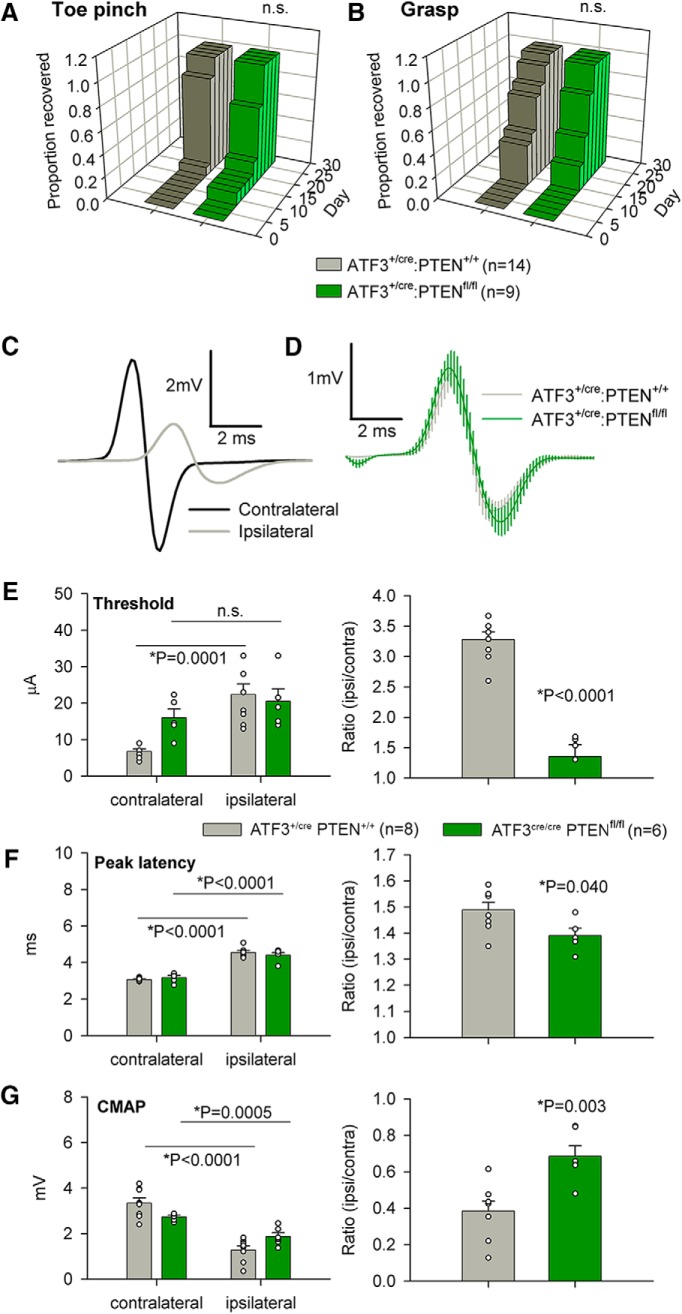
Axotomy-induced PTEN deletion and improves functional recovery following sciatic nerve crush. A, B, While there was no difference in recovery of reflex nociception or grasping in mice with floxed PTEN alleles (log rank Mantel–Cox test, n = 14 and n = 9 for ATF3+/cre:PTEN+/+ and ATF3+/cre:PTENfl/fl, respectively), EMG responses (C–G) indicated enhanced recovery of neuromuscular function. C, D, Representative EMG traces from ipsilateral and contralateral sides of an ATF3+/cre:PTEN+/+ mouse 28 d after sciatic nerve crush (C) and composite traces from eight ATF3+/cre:PTEN+/+ mice and six ATF3cre/cre:PTENfl/fl mice. E–G, Ipsilateral/contralateral ratios of EMG thresholds (E), peak EMG latencies (F), and maximum CMAP amplitudes (G) all indicated more complete muscle reinnervation 28 d after injury; n = 8 and n = 6 for ATF3+/cre:PTEN+/+ and ATF3+/cre:PTENfl/fl, respectively, averages were compared using paired t tests and ipsilateral/contralateral ratios with unpaired t tests.